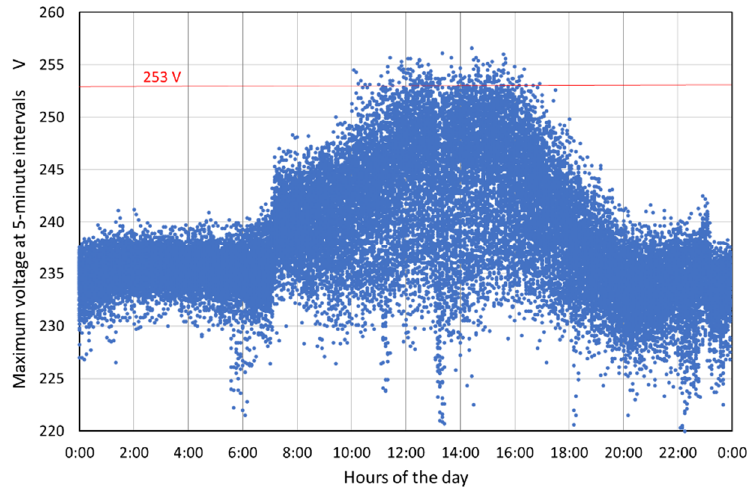
Figure 11. Measured voltage variability in the electrical socked in summer season.